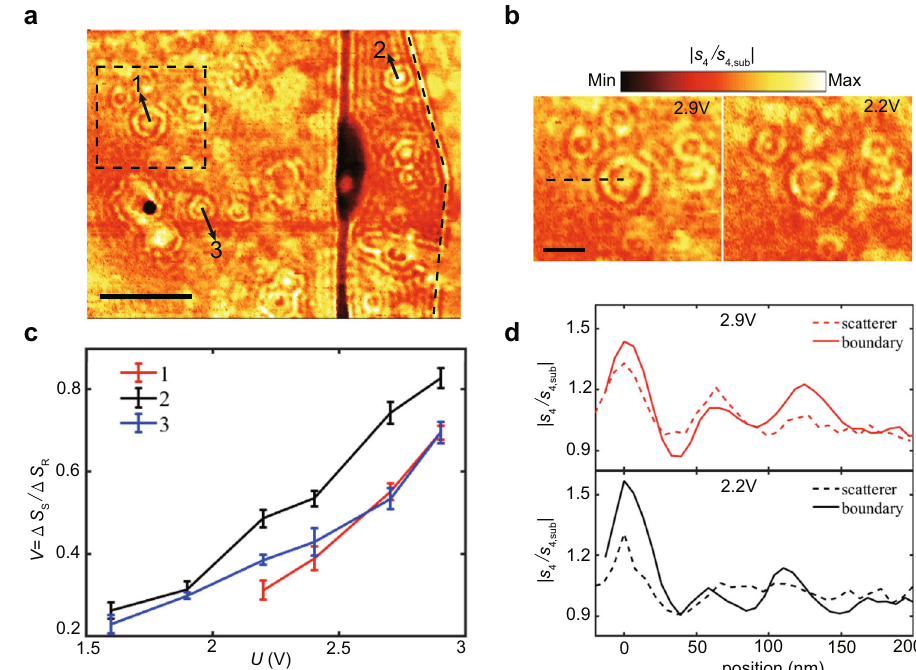
Fig. 3 The near- fi eld response of individual scatterers at the wavelength of λ = 10.653 μ m. a The near- fi eld image of the sample region over a 2.6 μ m × 2 μ m area under the gate voltage of 2.9 V. The black dashed line and rectangle show the boundary and the selected scatterer area of the h-BN encapsulated single-layer graphene, respectively. Three obvious isolated scatterers are labeled as 1, 2, and 3 by arrows. Scale bar, 500 nm. b Near- fi eld images of the acoustic graphene plasmons (AGPs) in the region of the black dashed square in ( a ) (the scatterer 1) at 2.9 and 2.2 V, respectively. The black dashed line represents the position where the detailed near- fi eld closed to the scatterer is investigated in ( d ). Scale bar, 300 nm. c The fringe visibility ( V ) for the three different scatterers as a function of the gate voltages U . The errors bars show the fl uctuation of Δ S S / Δ S R in different azimuthal directions close to the scatterers. d Comparison between the normalized near- fi eld signal S 4 / S 4,sub of the selected scatterer and the boundary of the graphene as a function of the voltages. The dashed and solid lines represent the scatterer and the boundary,